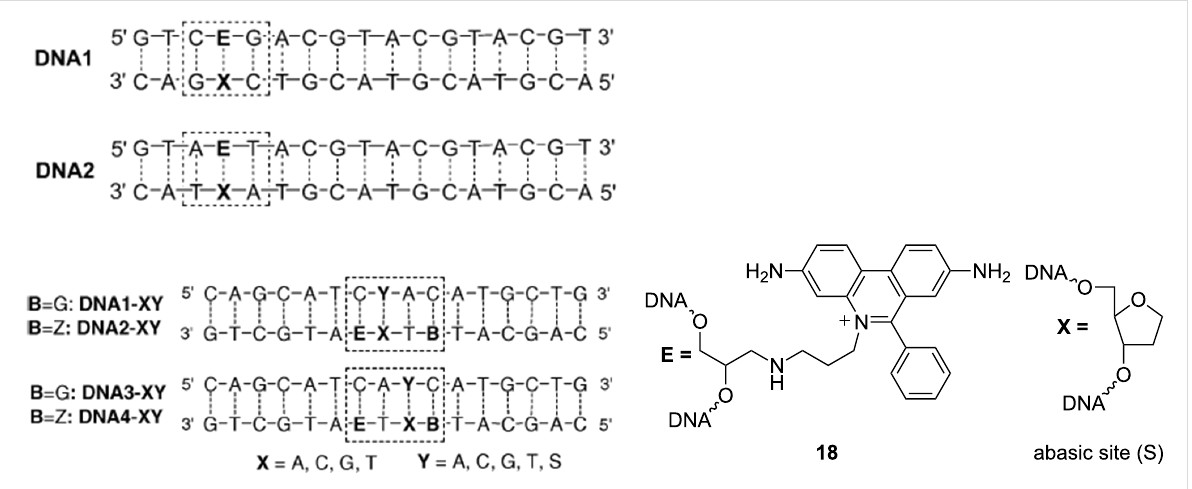
Figure 10: Left: various DNA duplexes; DNA1 and DNA2 used to study the impact on the adjacent basepair type on the EB fluorescence (repro- duced with permission from [90], copyright 2004 John Wiley & Sons, Inc.) and DNA1,2,3,4-XY studying the EB fluorescence quenching by 7-deaza- guanine (B) as a function of different position of abasic site (S). Reproduced with permission from [91] Copyright2005 Royal Society of Chemistry. Right: structure of incorporated EB ( 18 ) and of the abasic site